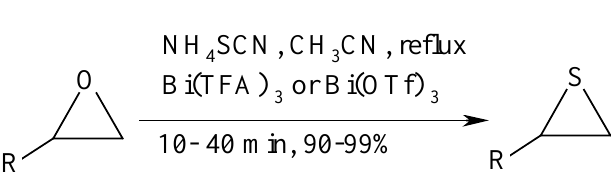
Table 1. Conversion of Epoxides to Thiiranes with NH